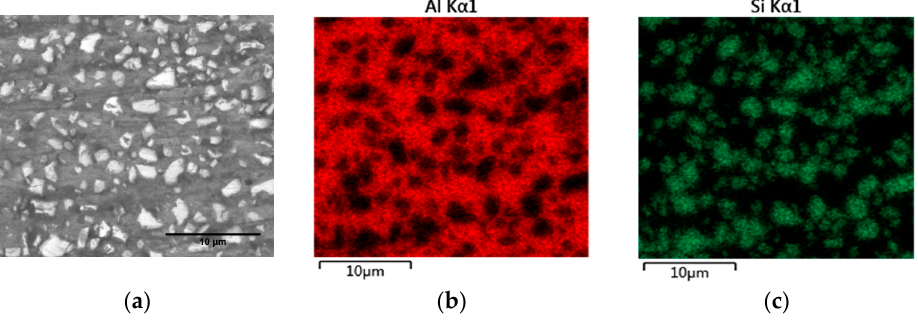
Figure 5. ( a ) The microscopic corrosion morphology and ( b , c ) EDS (Energy Dispersion Spectrum) surface scan spectrum of the exfoliation corrosion zone.